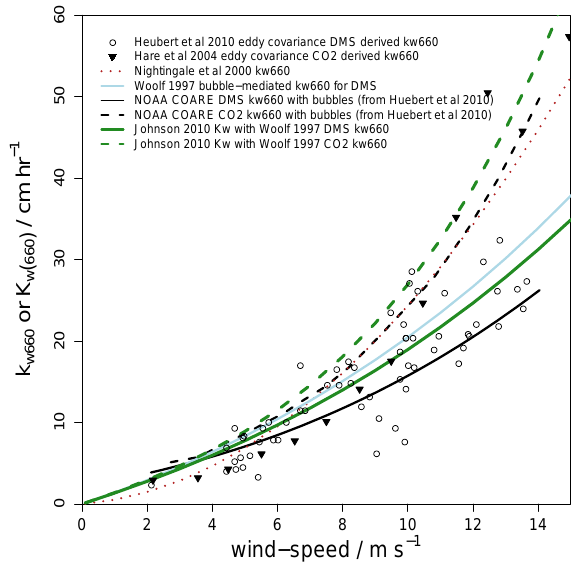
Fig. 7. Comparison of eddy covariance measurement derived trans- fer velocities for DMS and CO 2 normalised to a Schmidt number of 660, compared with NOAA COARE and various outputs from the scheme presented here. Note that total transfer velocities ( K w ) calculated using this scheme assume a temperature of 15 ◦ C, and do not normalise the air phase Schmidt